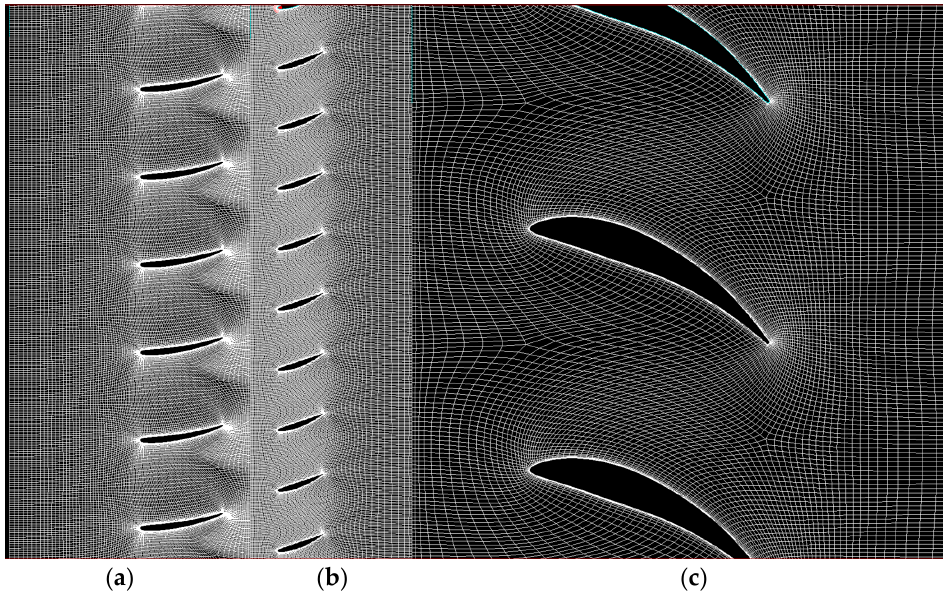
Figure 10. Blade-to-blade mesh for stay vanes ( a ), guide vanes ( b ), and rotor blades ( c ). Grid independency was checked by employing three different mesh densities for the nominal configuration case and evaluating the two main operating parameters of the turbine, i.e., the net head and the turbine hydraulic efficiency η . The results of the analysis are presented in Table 2. Table 2. Grid dependency results.